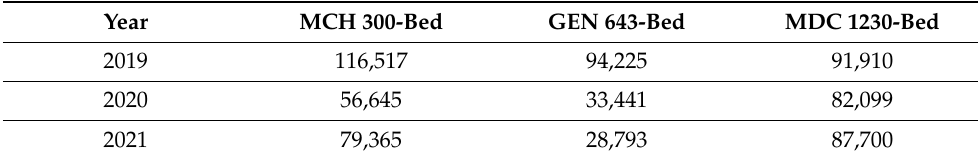
Table A1. Total Number of ED visits in each